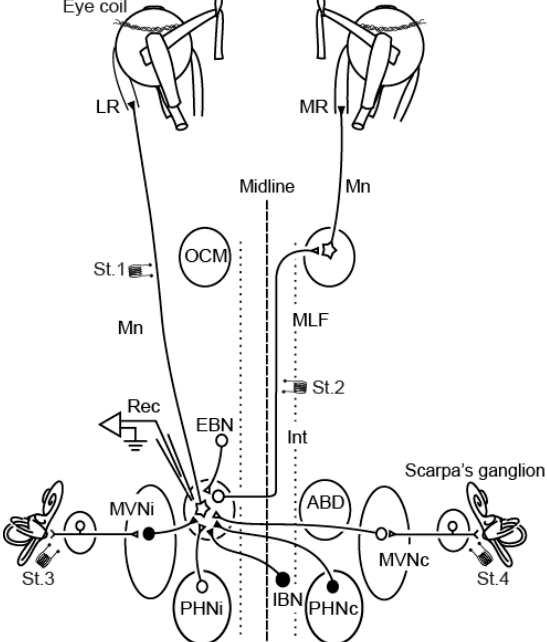
Figure 1. Diagram of the experimental design for chronic and acute recordings (Rec). The abducens nucleus (ABD) contains motoneurons (Mn) that innervate the lateral rectus muscle (LR) and internuclear neurons (Int) whose axons contact the contralateral medial rectus muscle (MR) innervating motoneurons of the oculomotor nucleus (OCM). Bipolar stimulating electrodes were implanted in the VIth nerve (St.1) and in the medial longitudinal fascicle (MLF; St.2); in some experiments, additional stimulation electrodes were implanted in the semicircular canals (St.3 and St.4). Inputs to ABD are illustrated: EBN and IBN, reticular excitatory and inhibitory burst neurons, respectively; PHN, prepositus hypoglossi nucleus; MVN, medial vestibular nucleus. The subscripts i and c indicate ipsilateral and contralateral, respectively, to the recorded ABD. Modified from [36].